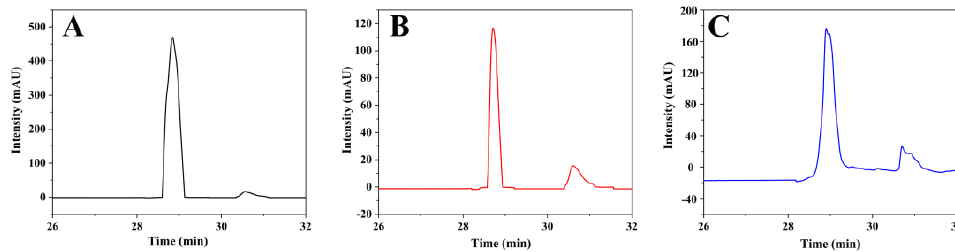
Figure 5. HPLC of PRL ( A ) without FMIPs, ( B ) with FMIPs at 60 ◦ C, and ( C ) with FMIPs at 80 ◦ C in Figure 5 . HPLC of PRL ( A ) without FMIPs, ( B ) with FMIPs at 60 °C, and ( C ) with FMIPs at 80 °C in simulated system. simulated system.